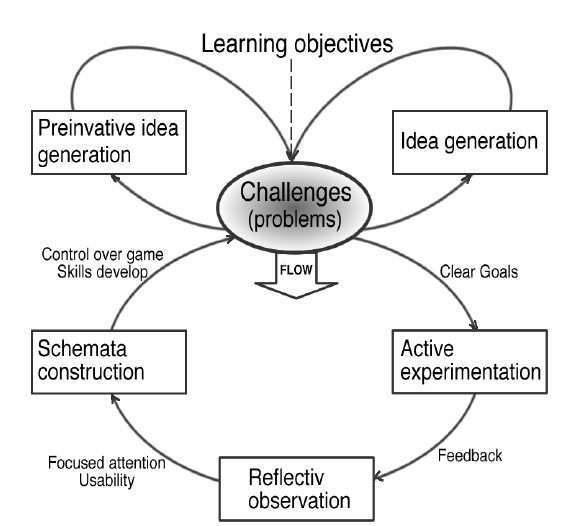
Figure 2. Framework of flow in computer-mediated environments